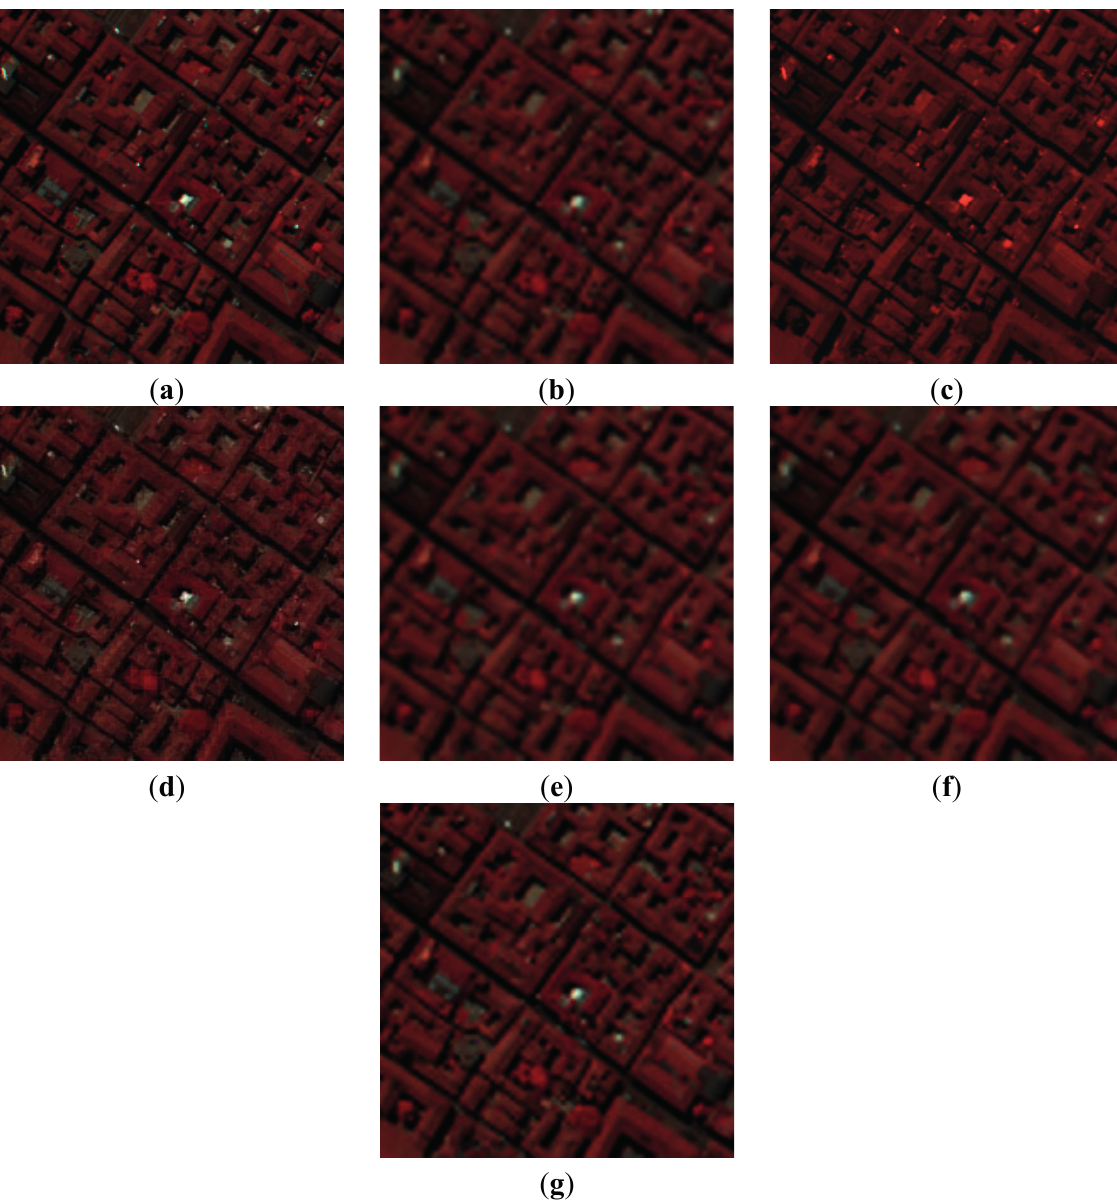
Figure 6. Experimental results of PaviaU HSI (color composite of R: 80, G: 28, B: 9). ( a ) the false color image of the original HSI; ( b ) bicubic interpolation; ( c ) PCA fusion method; ( d ) WT fusion method; ( e ) P + XS fusion method; ( f ) SR-SR method; ( g ) the proposed